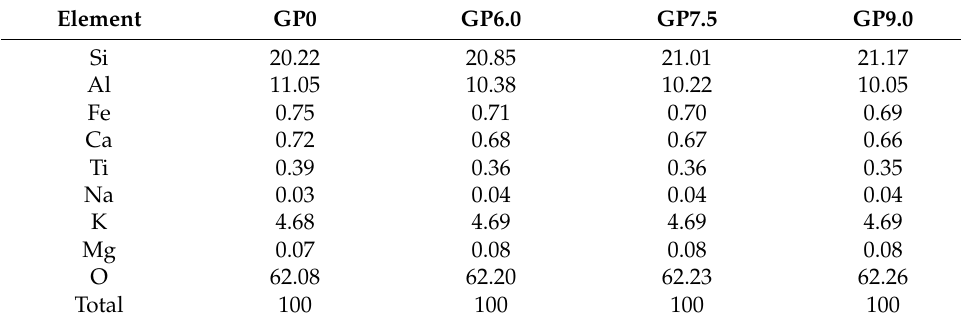
Table 3. Mole fraction of elements in the geopolymer